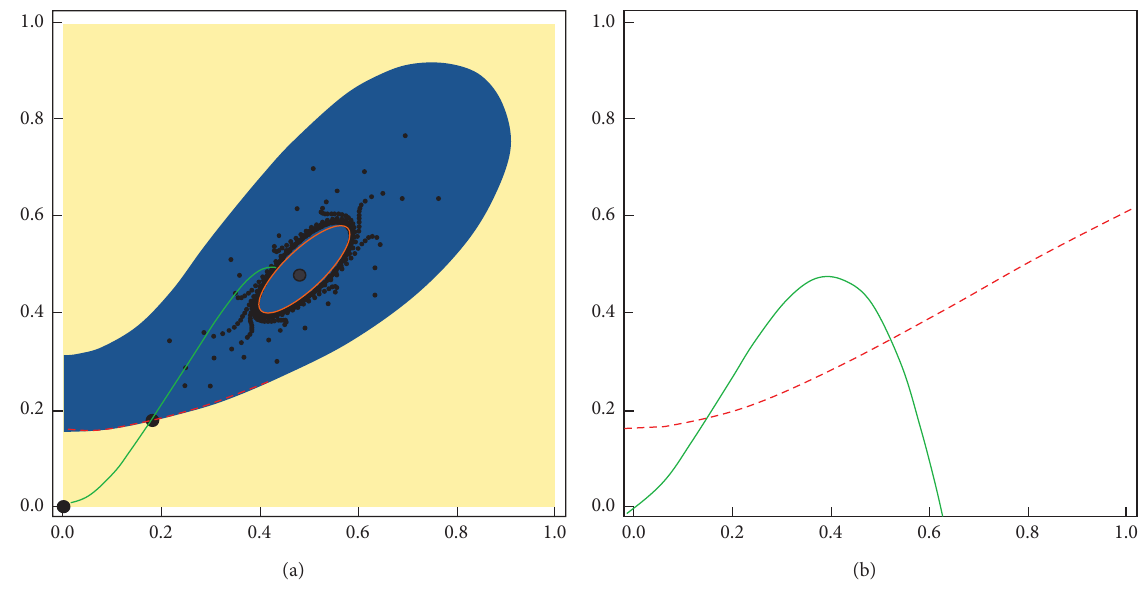
Figure 4: The local approximation of the stable (red) and unstable manifold (green) of equation (1) for a � 0 . 49 and f � 0 . 125 0.00.10.20.30.40.5